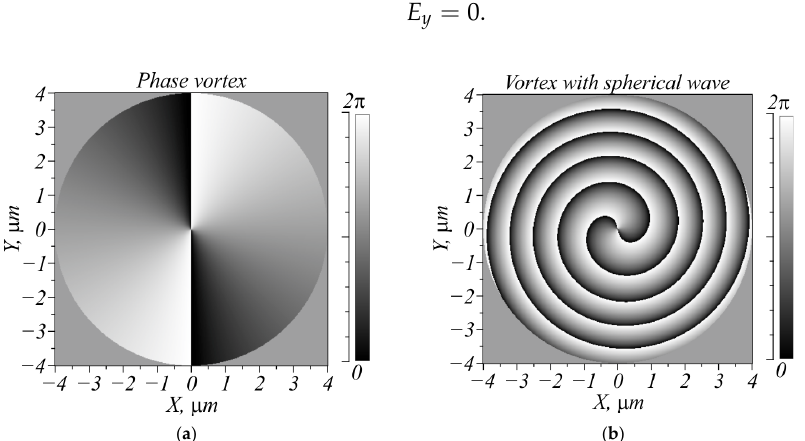
Figure 1. ( a ) A phase vortex with m = 2 embedded into an incident field and ( b ) the resulting phase of the initial field containing a spherical wave.